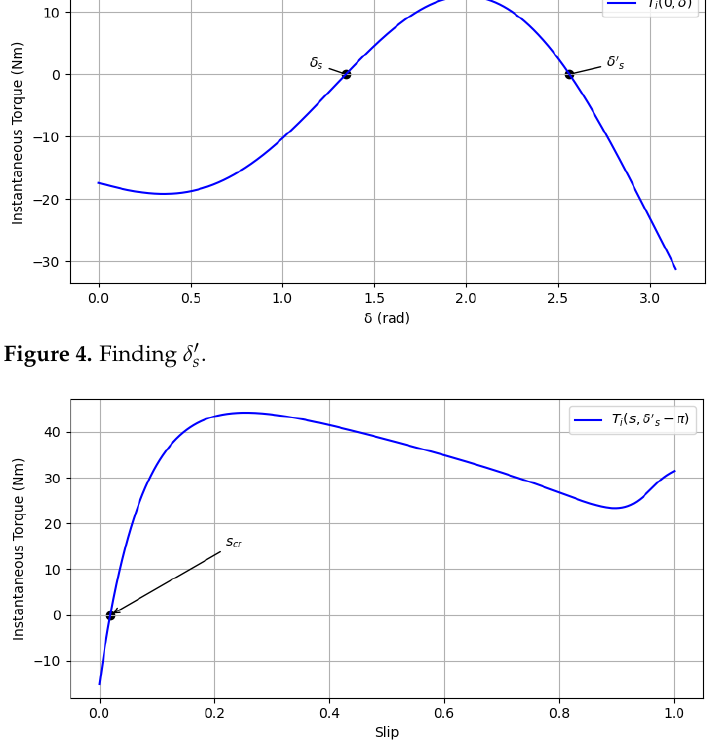
Figure 5. Finding the critical